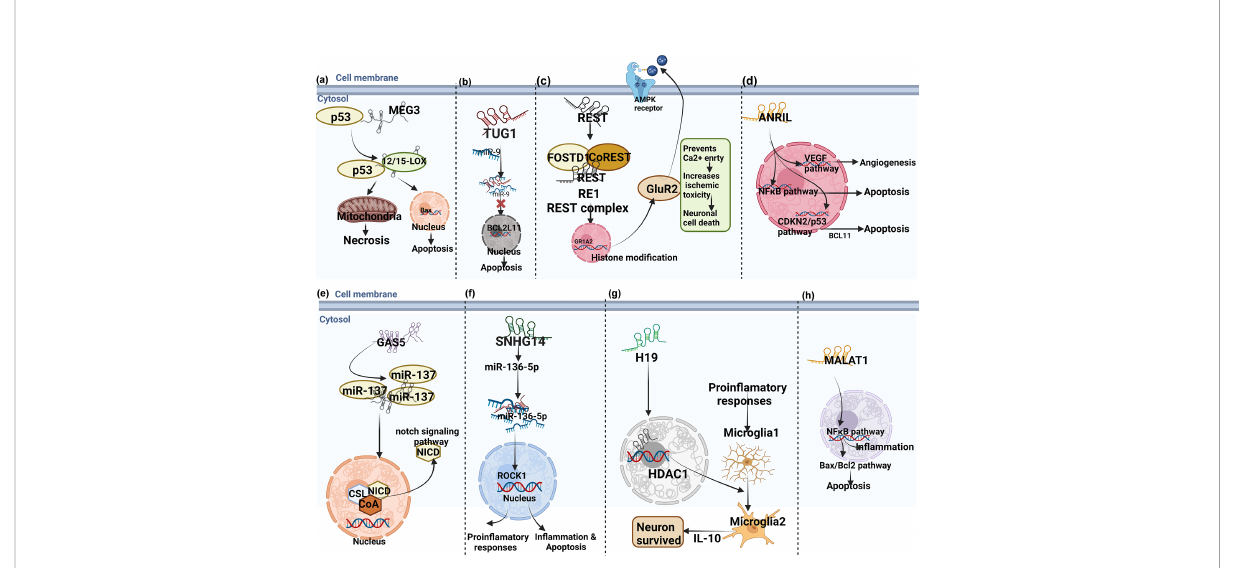
FIGURE 3 The mechanisms of lncRNAs in cerebral ischemia/ischemia-reperfusion injury. ( A – H are schematic diagrams of the mechanism of several lncRNAs regulating neuroin fl ammation in regulating neuroimmune in fl ammation in cerebral ischemia/ischemia-reperfusion